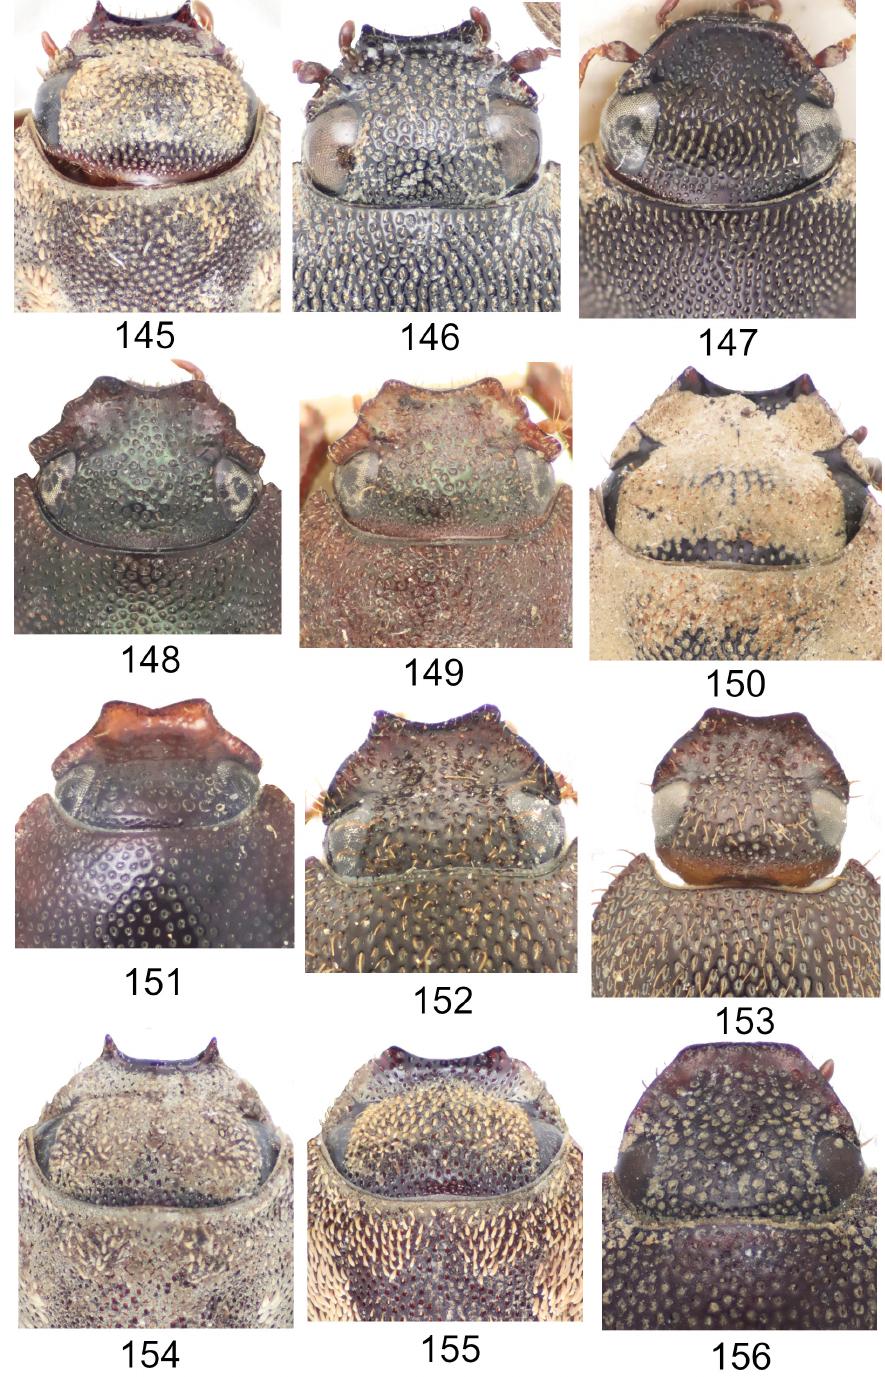
Figs 145–156. Papuan Maechidius Macleay, 1819, head, dorsal view. 145 . M. merdeka sp.